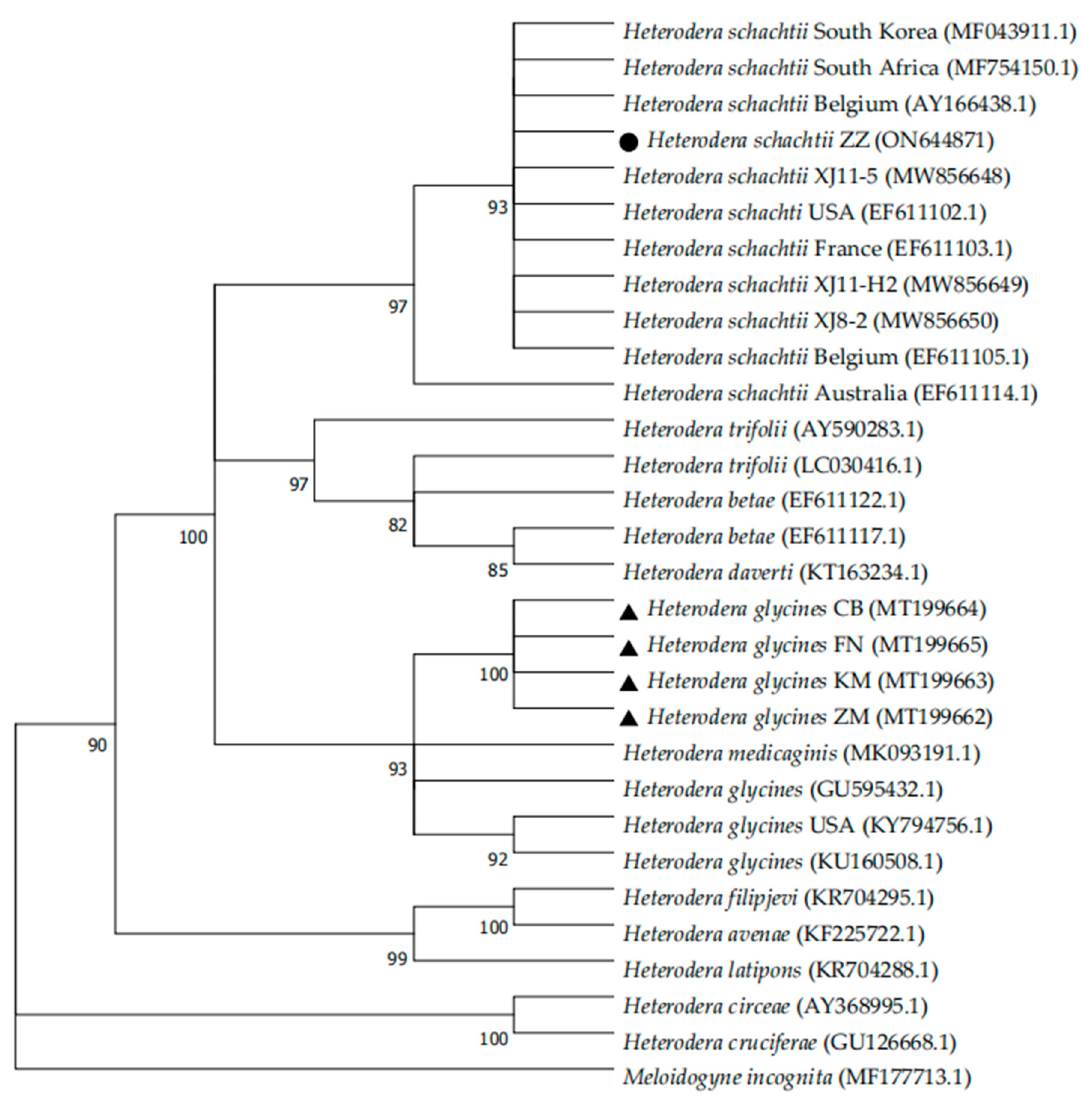
Figure 2. Phylogenetic tree of cyst nematodes collected from Bashang and other Heterodera species based on the rDNA-ITS sequences by using the maximum likelihood model. Meloidogyne incognita was selected as the outgroup. Numbers are bootstrap values.